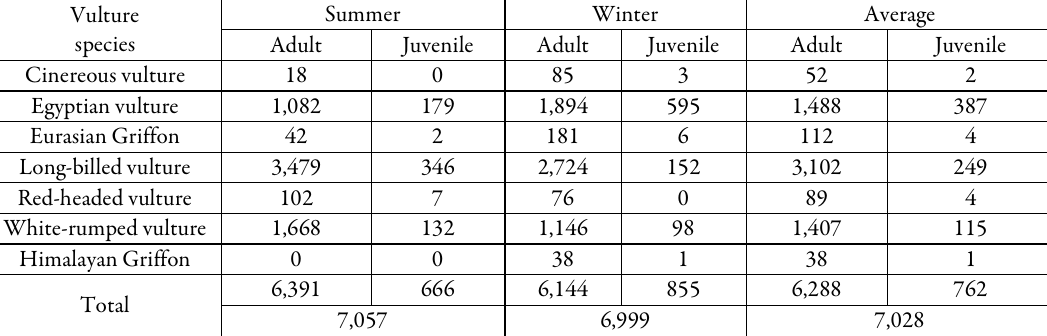
Figure 3. Spatial distribution of vulture species in the study area. Circular spots are the roosting or nesting locations of winter and summer combined. Note that almost all sites (87%) are in forested area (left), while very few (13%) in agriculture land use area (right) Table 3. Population of different vulture species in Central India as per 2016